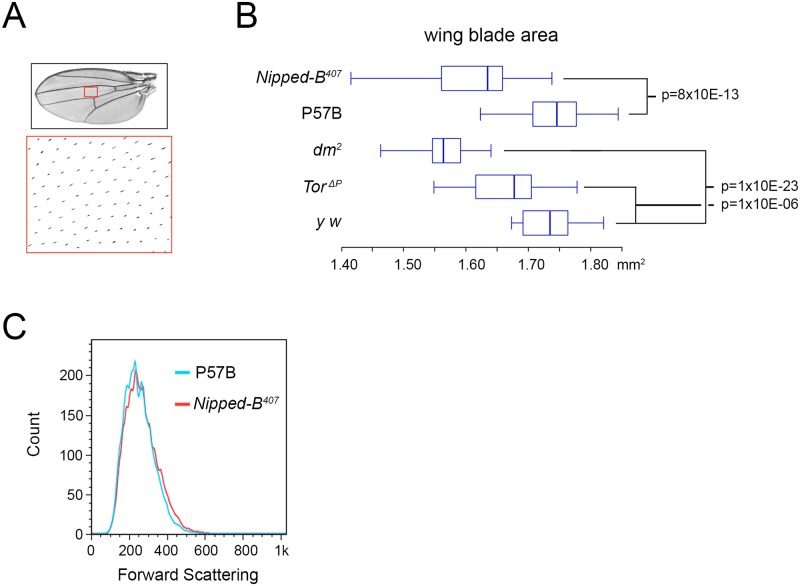

Nipped-B, dm, and Tor mutations reduce adult wing size.(A) Full adult female wing areas were measured, and areas of wings (red boxes) were sampled for the number of cells by counting the hairs produced by each cell at higher magnification (large red box) to determine cell size and number (Table 2). (B) Box plots showing the distributions of wing blade areas of the indicated genotypes: Nipped-B
407 (Nipped-B
407
/+), P57B (P57B/+), dm
2 (dm
2
/+), Tor
ΔP (Tor
ΔP
/+), y w (y w/+). The p values of various pairwise comparisons determined by the student t test are indicated. (C) Late 3rd instar wing discs were dissected from larvae with the indicated genotypes, dissociated with trypsin and collagenase, and sorted by forward scattering in cell sorter to measure the distributions of cell sizes.